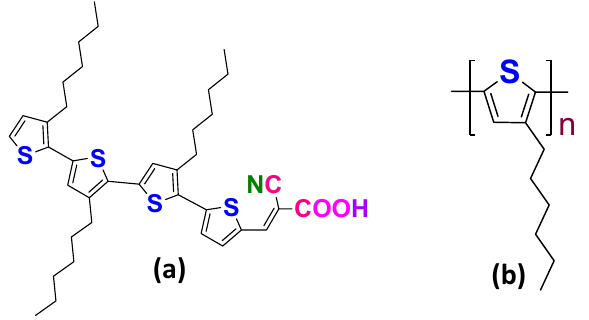
Figure 1. Chemical structures of ( a ) 4T dye and ( b ) P3HT polymer. Both structures have hexyl-substituted thiophene ring as a common